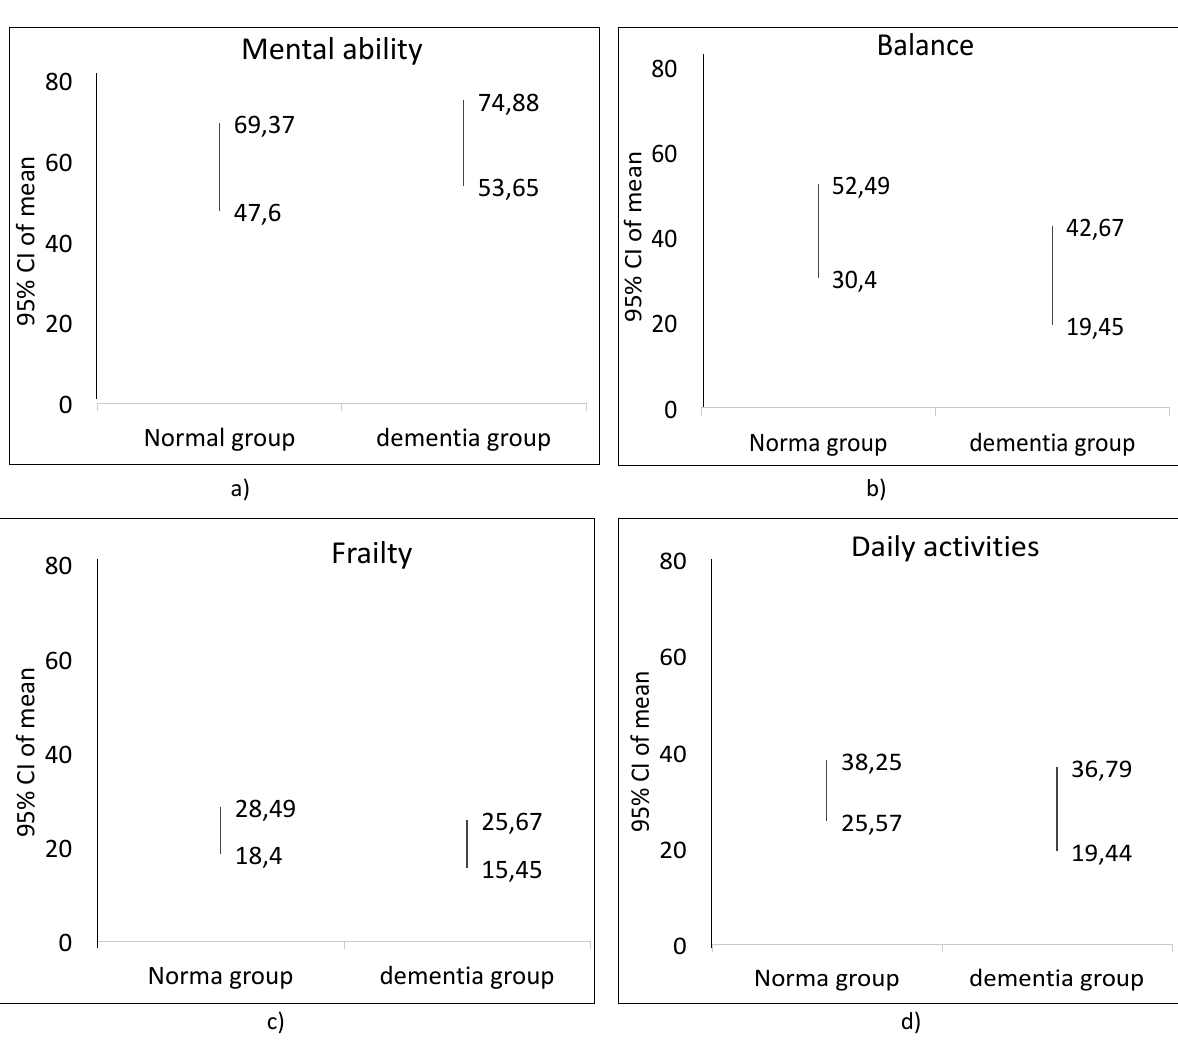
Figure 1. The effects of exercise on outcome measures. The means and 95% confidence intervals (CIs) for two groups on (a) mental ability, (b) performance-oriented balance, (c) frailty (FR test) and (d) performance in